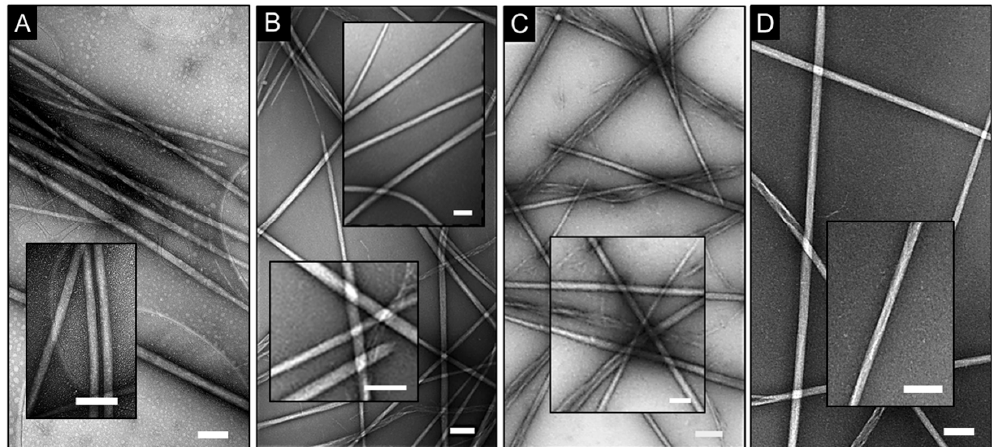
Figure 3. Negative staining on different substrates. Electron micrograph of model 4 on copper grids coated with holey carbon and graphene oxide ( A ), Formvar and carbon films ( B ), Formvar and silicon monoxide coatings ( C ) and silicon nitride TEM window ( D ). Scale bars are 250 nm. Insets highlight cross ‐ sectioned fibers. Staining conditions: uranyl acetate (aq. 2%, w/v). Some coatings, such as graphene oxide, can carry a negative charge. Negatively stained